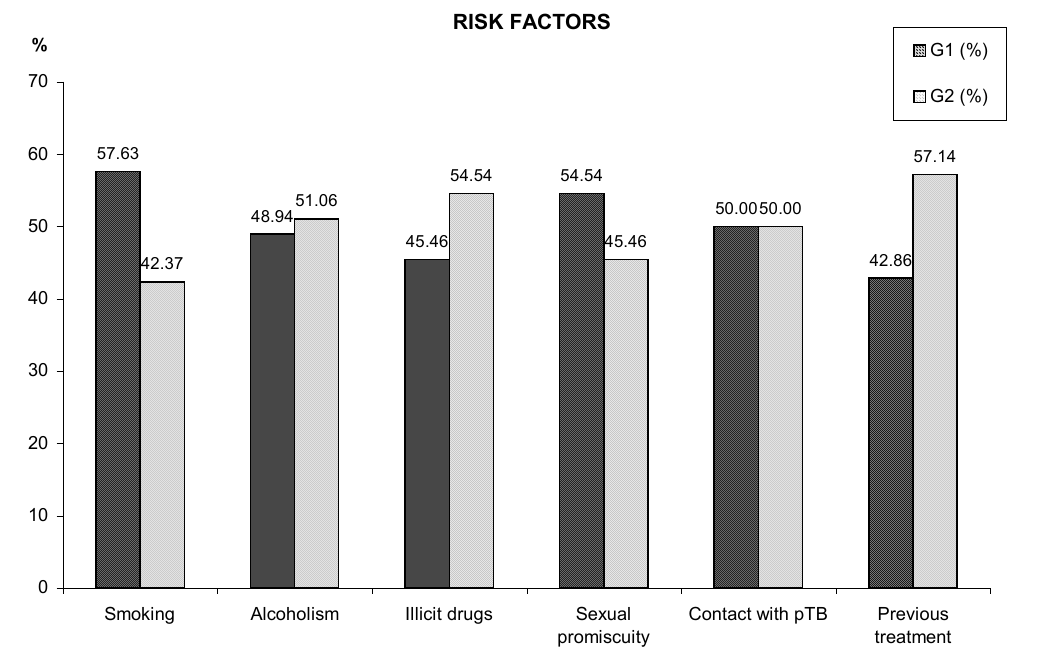
Figure 1. Risk factors associated with pulmonary tuberculosis